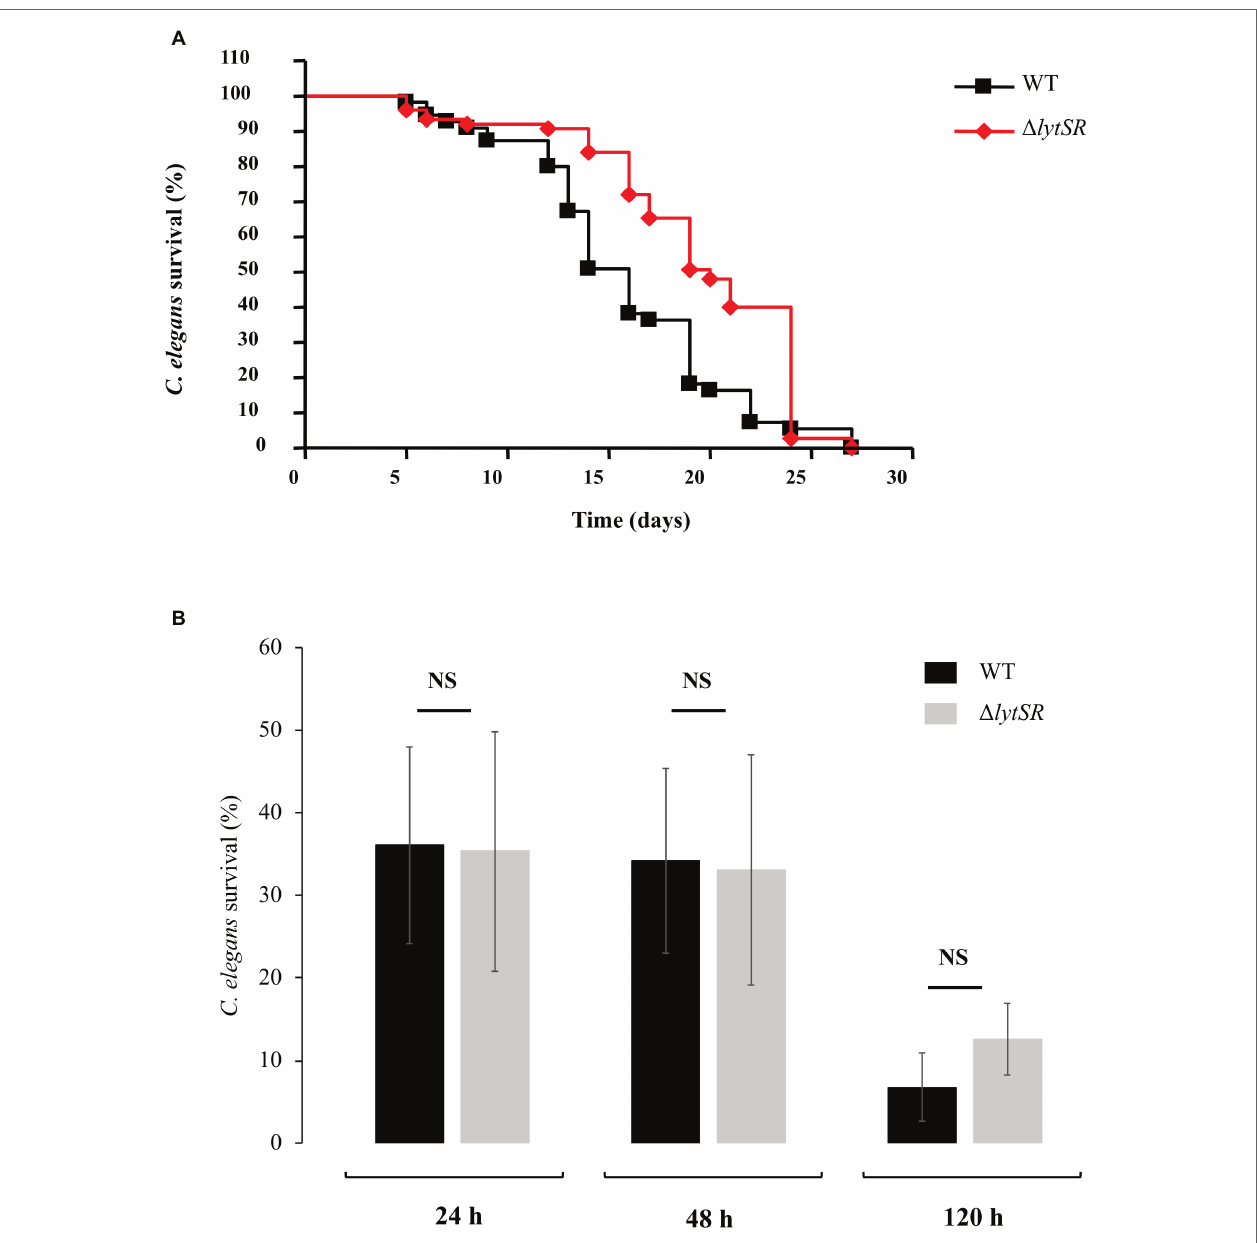
FIGURE 5 | S. lugdunensis virulence toward Caenorhabditis elegans worms. (A) Kinetics of survival of C. elegans fed with WT and Δ lytSR strains in solid killing assay. Each value is the mean of measurement of eight replicates from two independent preparations. Nematode survival was calculated by the Kaplan-Meier method, and survival differences were tested for significance using the log rank test. The survival kinetics of C. elegans was significantly increased in the presence of Δ lytSR strain ( p < 0.0001). (B) Liquid killing assay of C. elegans exposed to the supernatant of WT and Δ lytSR strains. Nematode survival was evaluated after 24, 48, and 120 h of exposure. Each value is the mean ± SEM of measurement of eight replicates from six independent preparations. The nonparametric Mann-Whitney U test was used to compare the means within the same set of experiments. NS, not